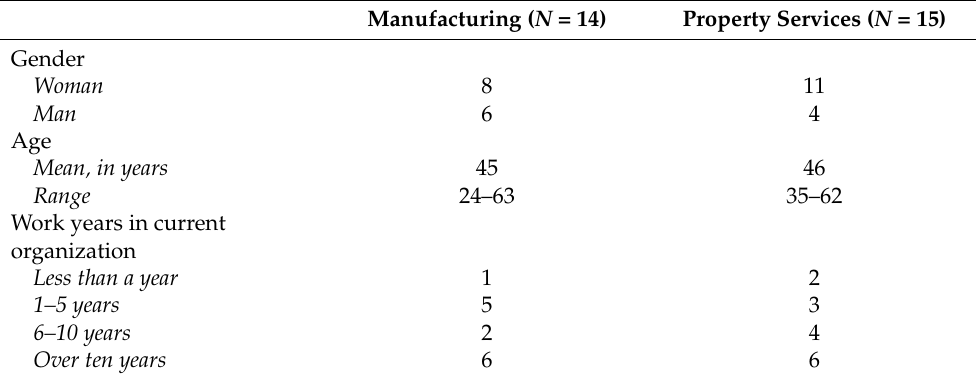
Table 2. Interview